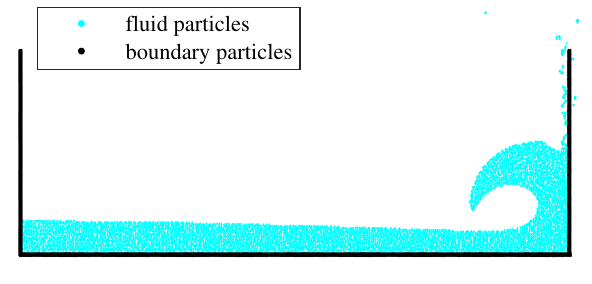
Fig. 3. The rolling wave. T = 5 . 9